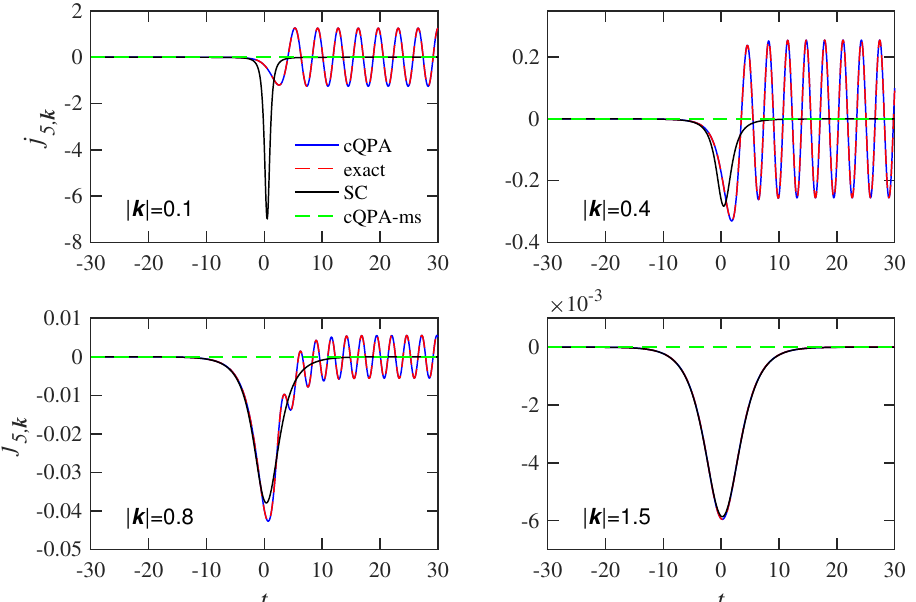
Figure 7. The helicity summed axial charge density j 5 ; k from the exact solutions (red dashed line), and from the semiclassical approximation (black line). Blue solid line (exactly matching the red dashed line) is the full cQPA solution and the green line is cQPA solution restricted to the mass shells. In each (cid:12)gure we have m 1R = 0 : 1, m 2R = 1, m I = 0 : 1, (cid:28) w = 5 and (cid:0) = 0 : 2, while j k j = 0 : 1 ; 0 : 4 ; 0 : 8 and 1 : 5 in di(cid:11)erent panels as indicated.